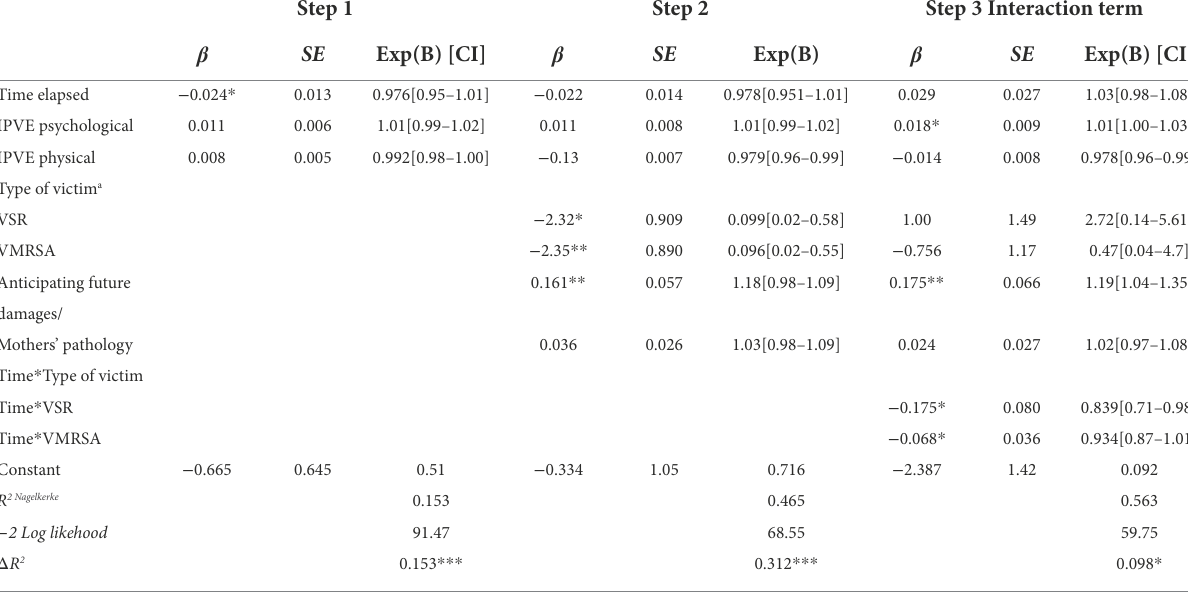
TABLE 3 Hierarchical logistic regression models predicting children’s pathological anxiety after IPV exposure.